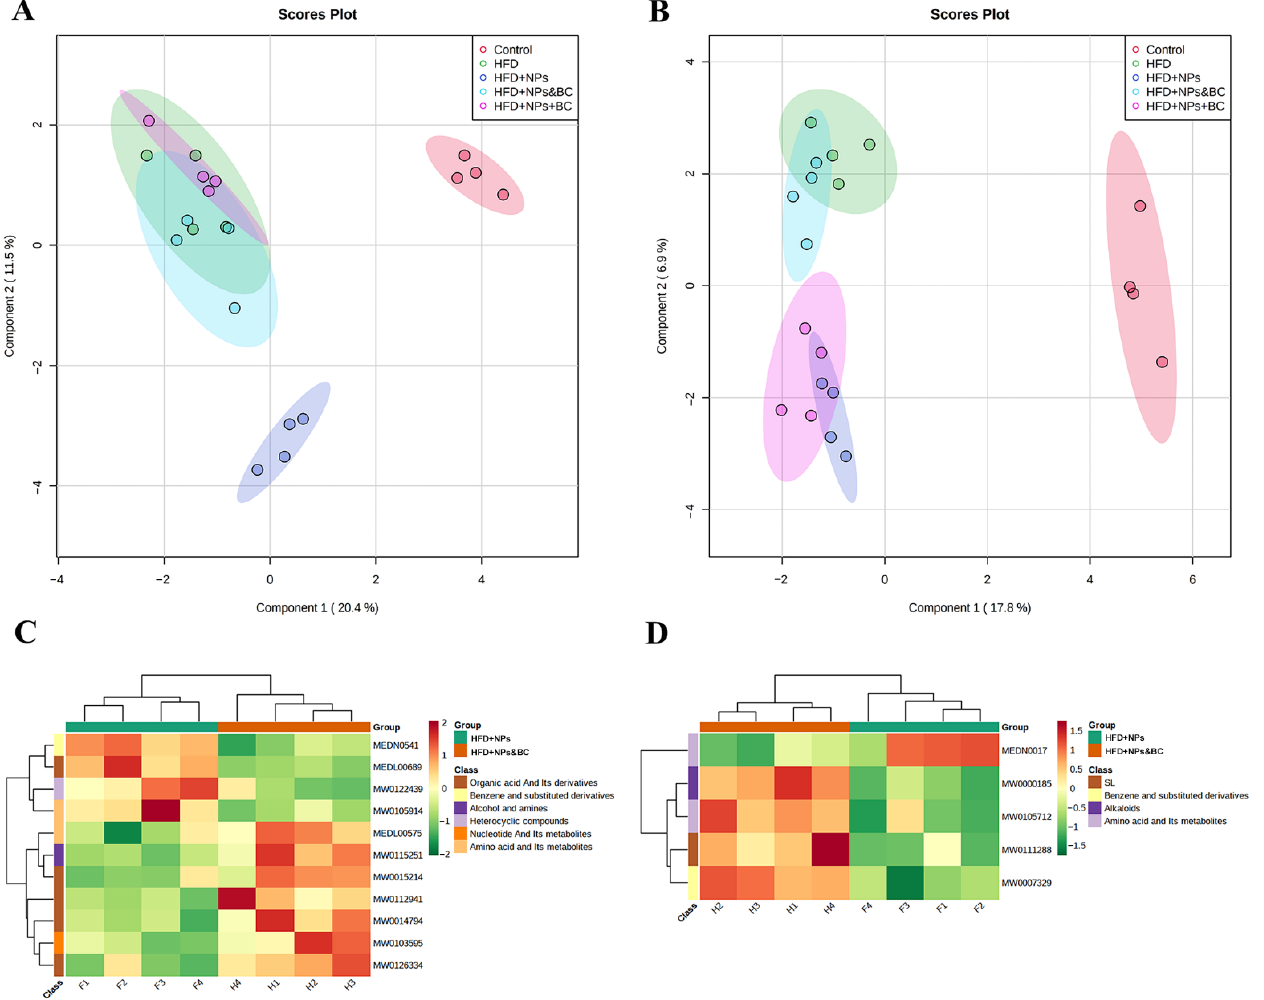
Figure 8. sPLS – DA score plots for each group in ( A ) the negative-ion mode and ( B ) the positive-ion mode. KEGG pathway analysis of differential metabolites for each group in ( C ) the negative-ion mode. KEGG pathway analysis of differential metabolites for each group in ( C ) the negative-ion mode and ( D ) the positive-ion mode. mode and ( D ) the positive-ion